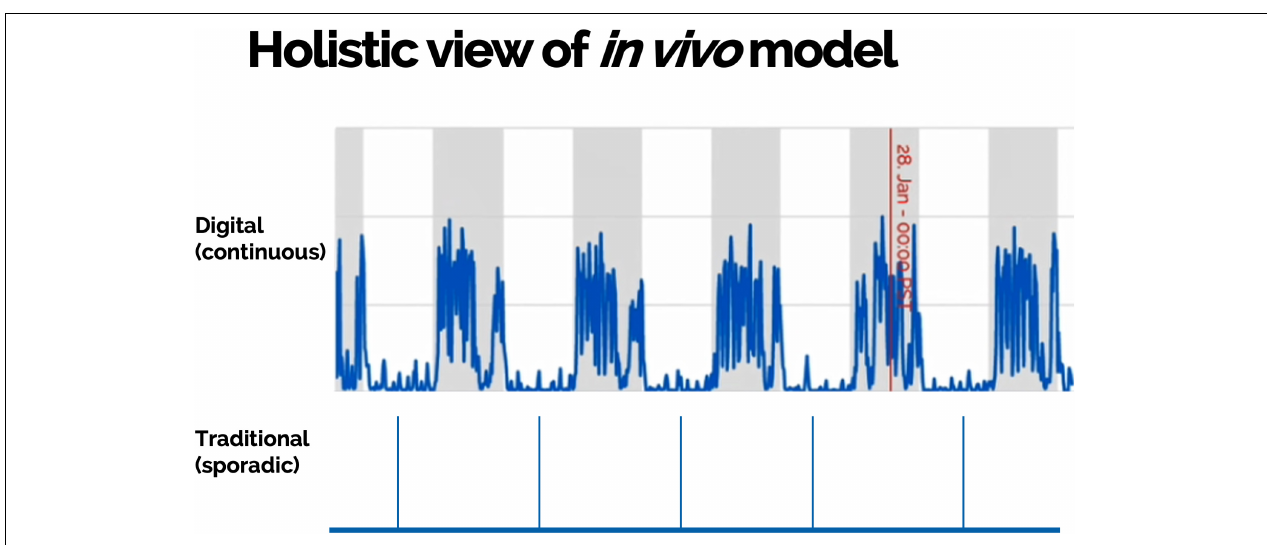
FIGURE 6 | Multiple measurements collected continuously and remotely within animals’ home environment can provide a holistic view of an in vivo model including objective assessment of disease development and